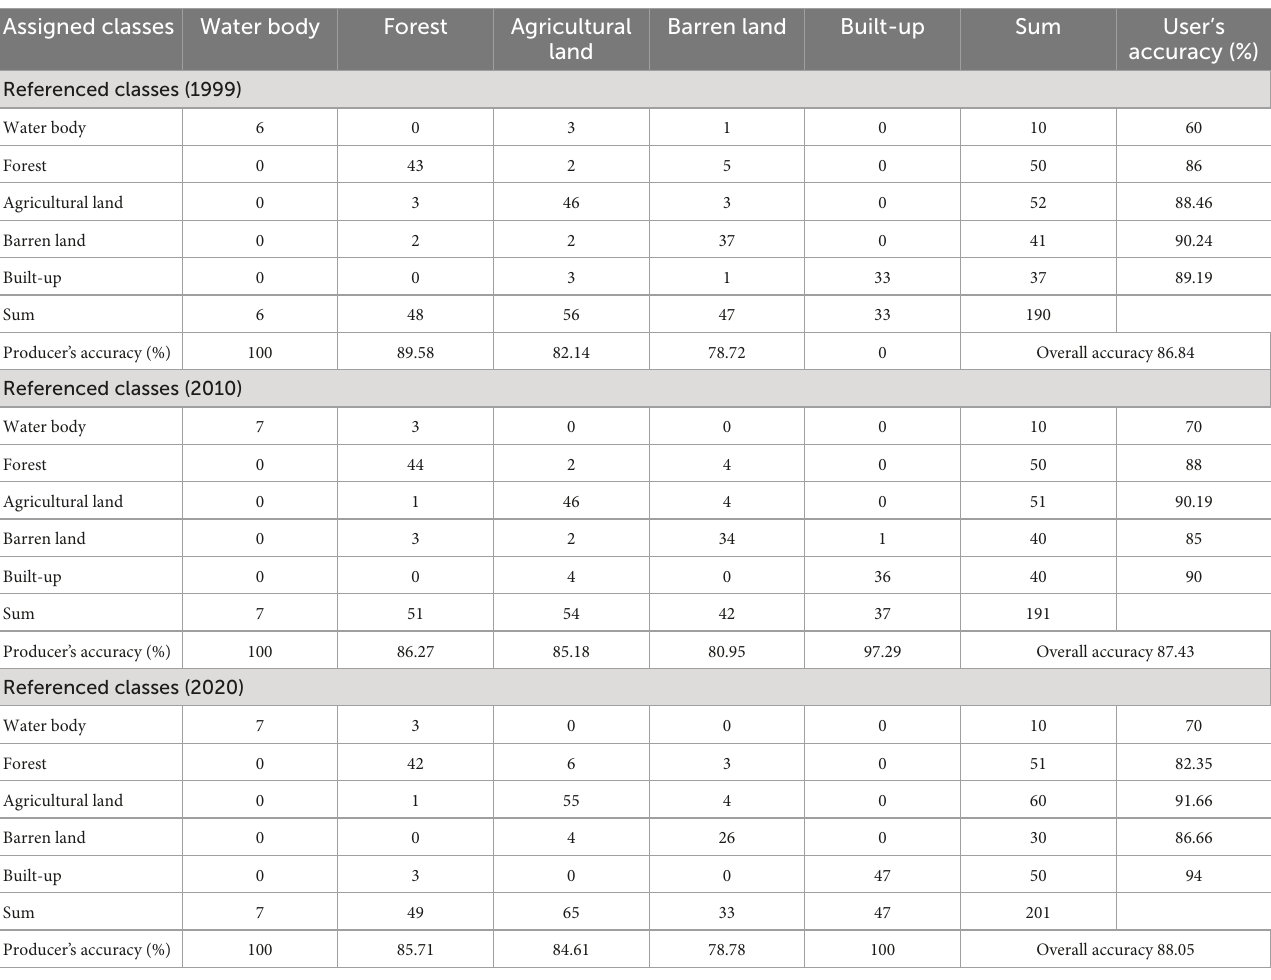
TABLE 5 Confusion matrix for LULC classification for the years 1999, 2010, and 2020. Assigned classes